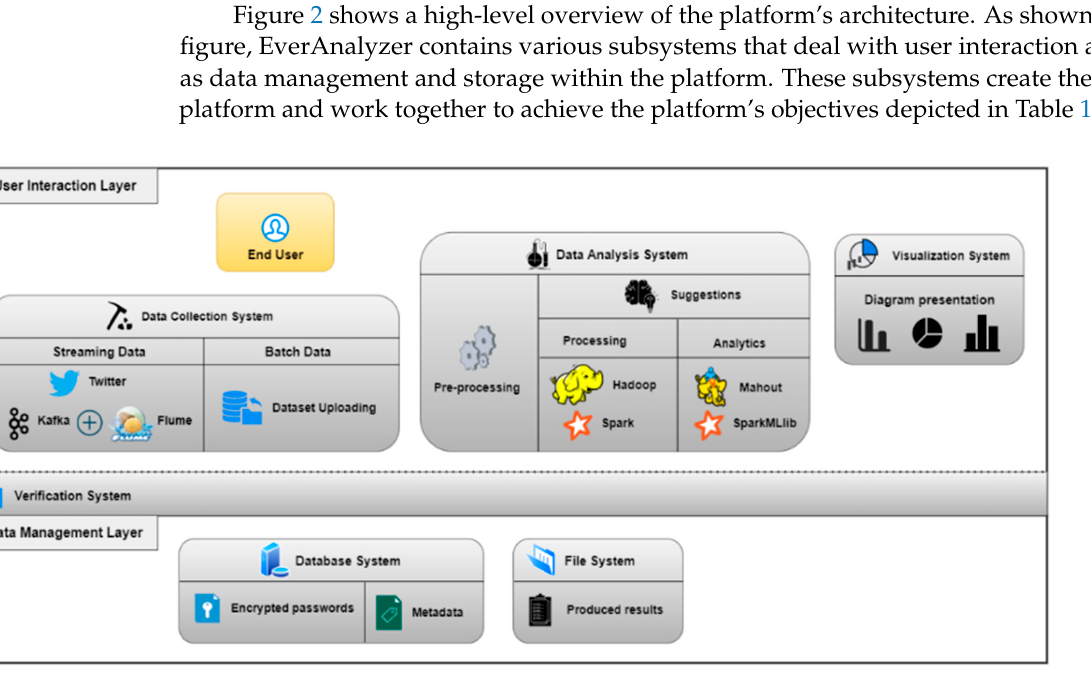
Figure 2. EverAnalyzer High Level